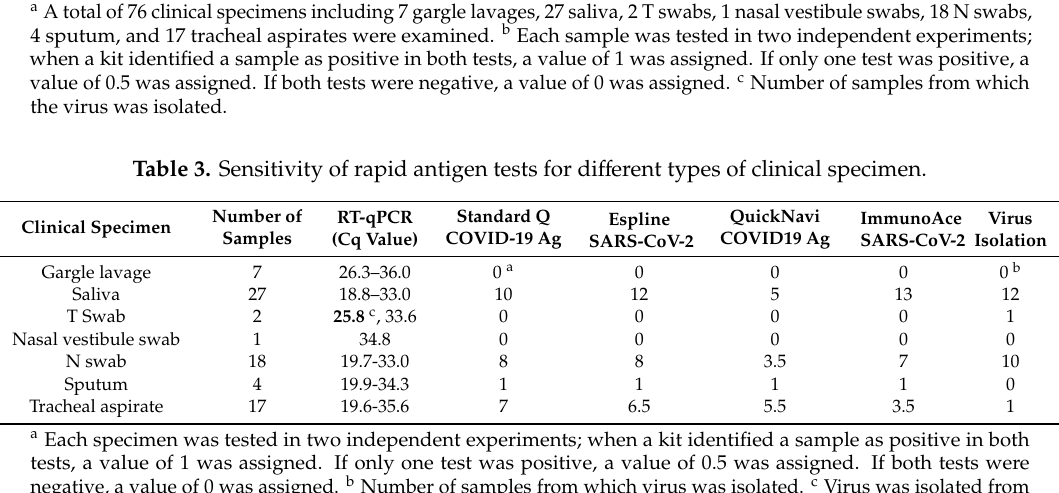
(Table S2). Standard Q COVID-19 Ag and ImmunoAce SARS-CoV-2 detected as little as 250 PFU of NC02, whereas Espline SARS-CoV-2 and QuickNavi -COVID19 Ag detected 500 PFU and 750 PFU of NC02, respectively (Table S2). Standard Q COVID-19 Ag and Espline SARS-CoV-2 detected as little as 250 PFU of HP72, whereas QuickNavi COVID19 Ag and ImmunoAce SARS-CoV-2 detected 5000 PFU of HP72. These results show that the sensitivity for virus detection of Standard Q COVID-19 Ag and Espline SARS-CoV-2 was better than that of QuickNavi COVID19 Ag, and that virus detection by ImmunoAce SARS-CoV-2 di ff ered depending on the